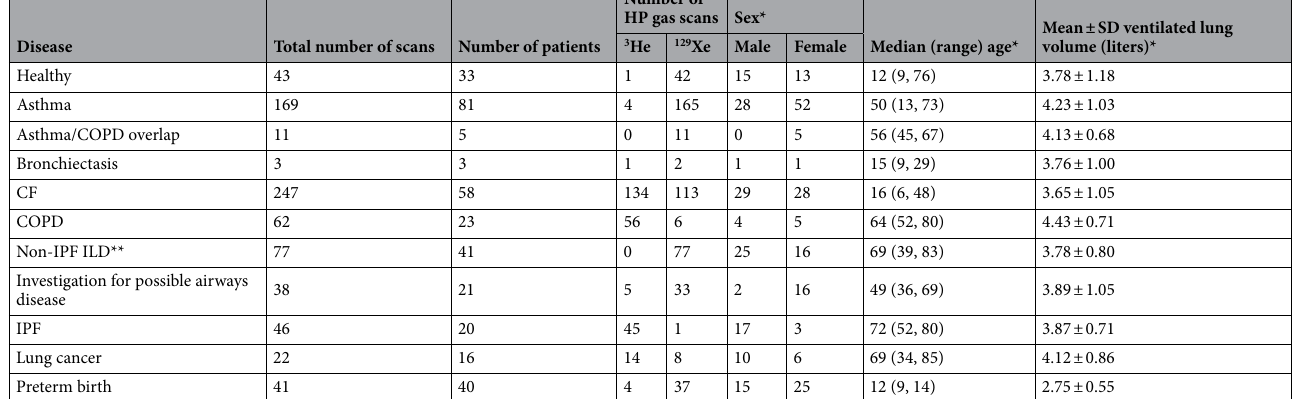
Table 1. Summary of demographics, clinical characteristics and image dataset information stratified by disease. HP hyperpolarized, CF cystic fibrosis, COPD chronic obstructive pulmonary disease, ILD interstitial lung disease, IPF idiopathic pulmonary fibrosis, SD standard deviation. *Data for 25 patients was unavailable. **Contains connective tissue disease-associated ILD (CTD-ILD), hypersensitivity pneumonitis and drug- induced ILD